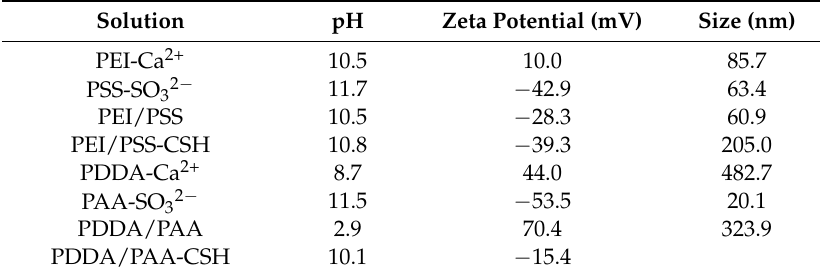
Table 1. pH, zeta potential value, and particle size of the polymer/ion